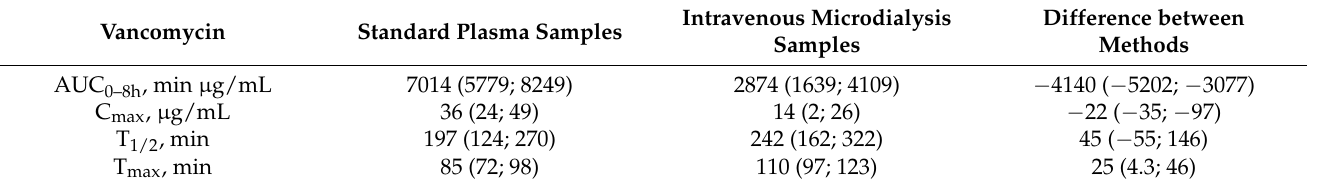
Table 1. Pharmacokinetic comparison between standard plasma samples and intravenous microdial- ysis samples for